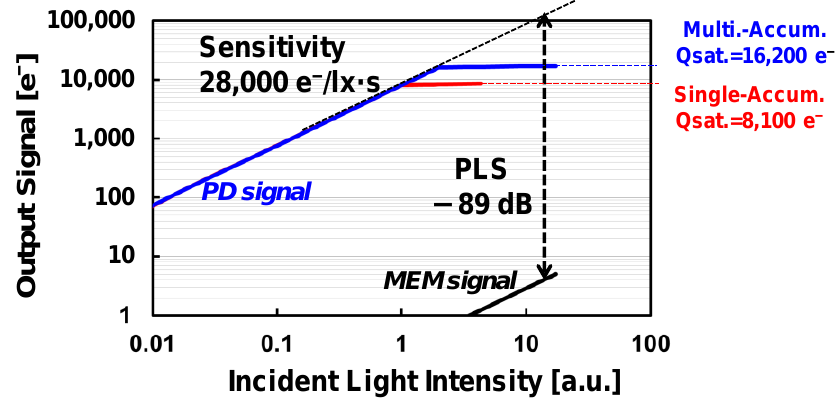
Figure 10. Measured output characteristics.